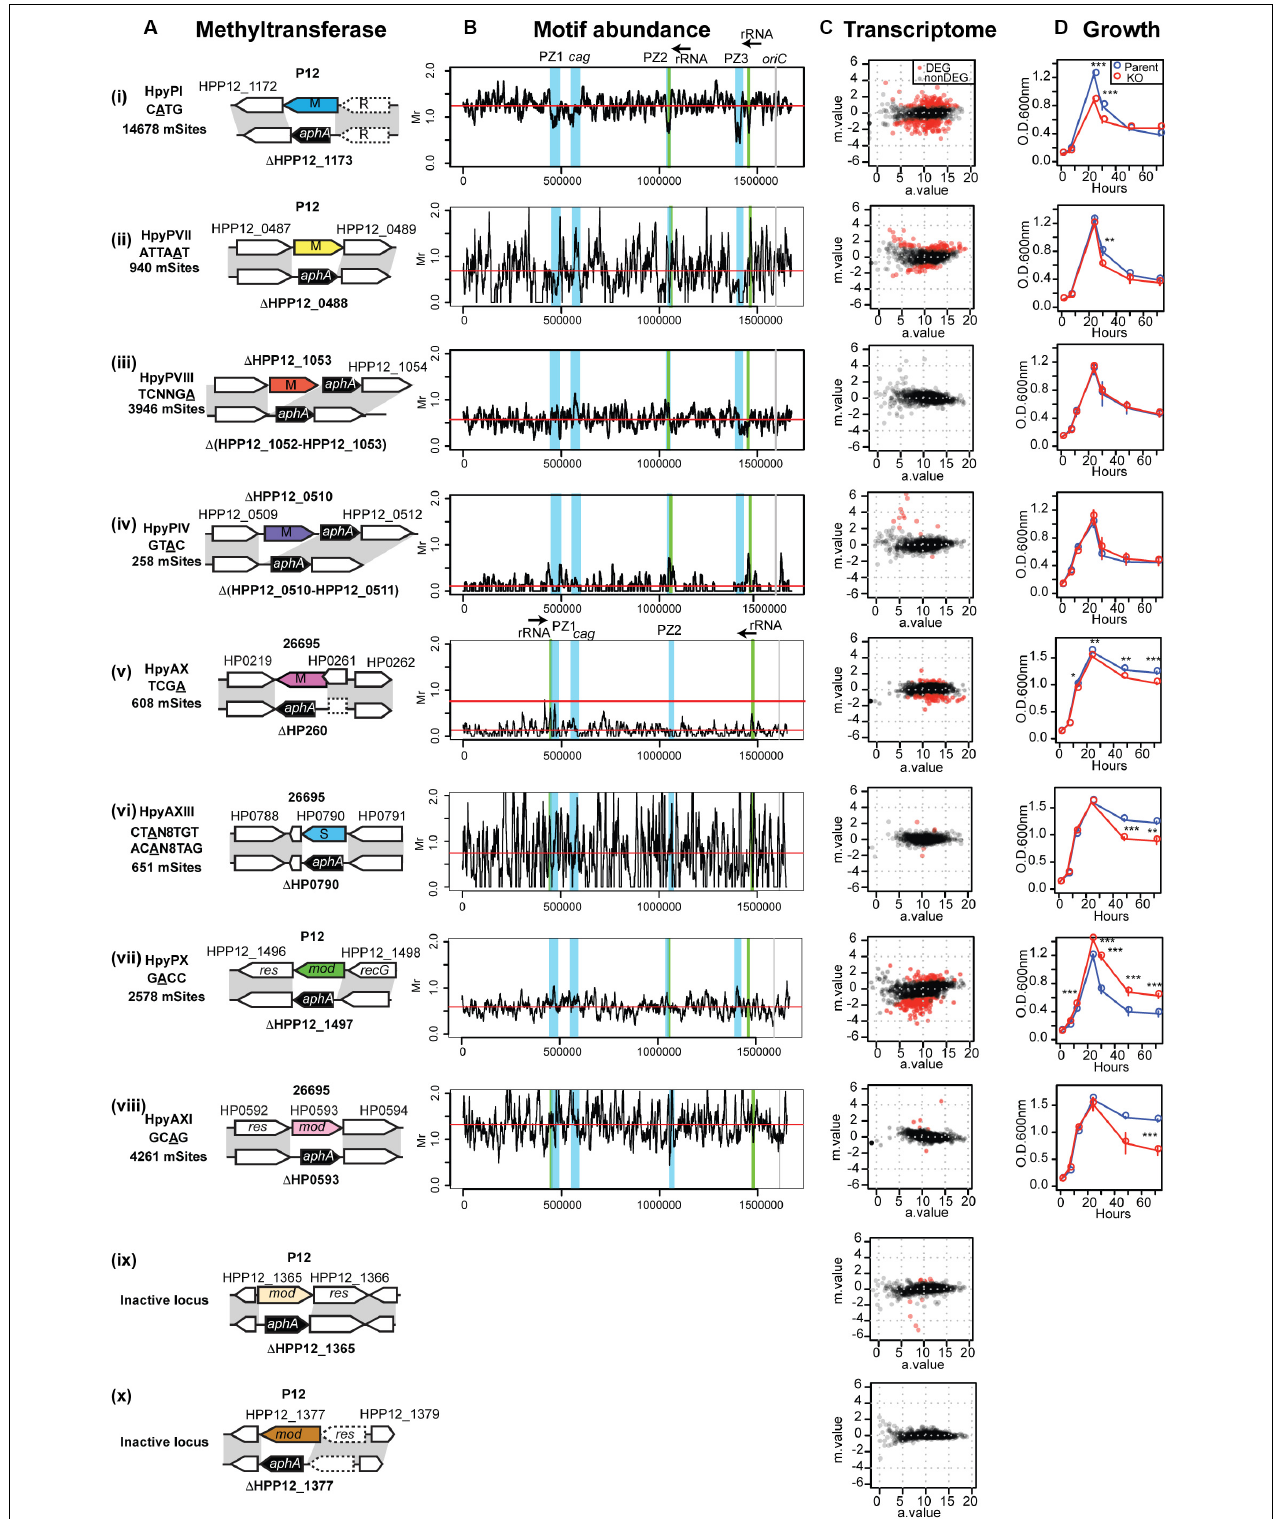
FIGURE 2 | Methyltransferases, their target distribution, knockouts’ effects on transcriptome and growth. (A) Methlyltransferase name, target motif with methylated base underlined, and its number per genome (mSites). Parental strain (P12 or 26695), locus tag, genetic maps around the methylation specificity gene and